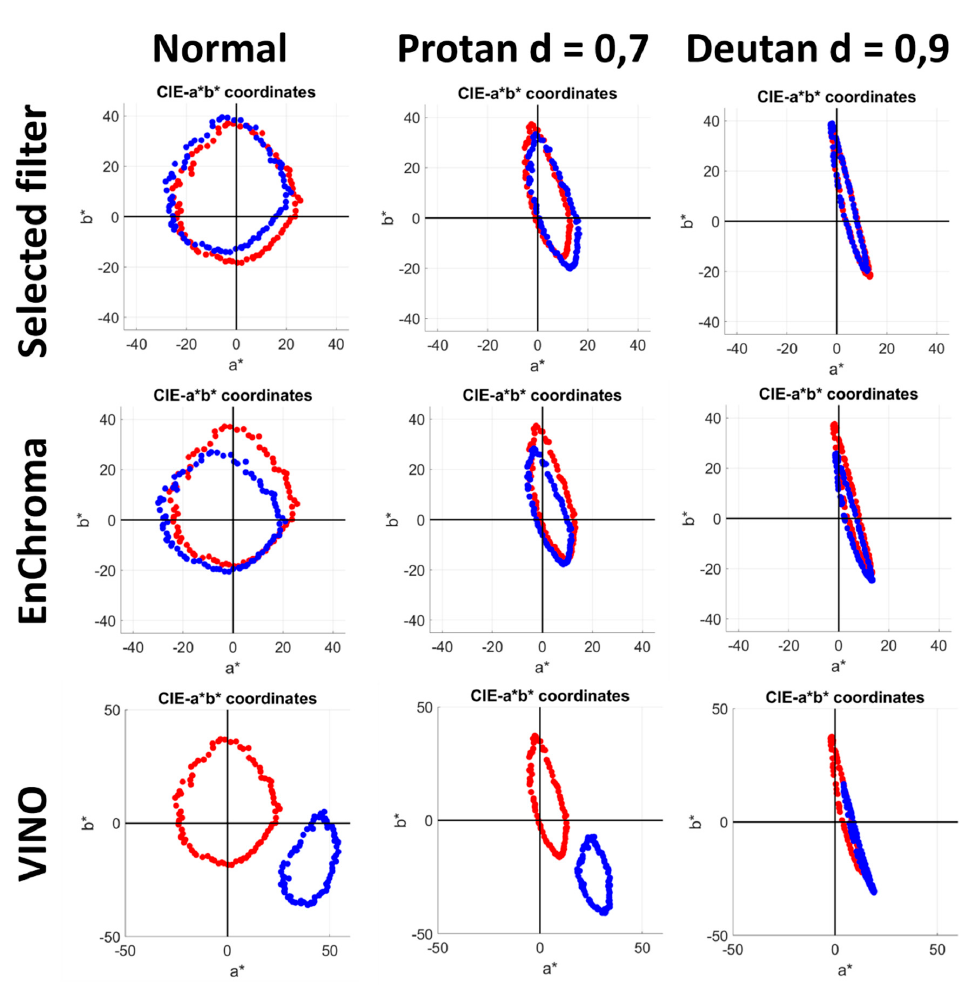
Figure 10. a*-b* color charts with FM100 samples plotted for normal (left), protanomalous (middle), and deuteranomalous (right) simulated observers, in the filtered (blue) and unfiltered (red) conditions. First row: selected filter; second row, EnChroma filter; third row: VINO filter. Table 5. Quadratic Total Error Score (SQR), Angle, C-Index, and S-Index computed for each simulated observer in the filtered (with the best-performing filter) and unfiltered conditions.